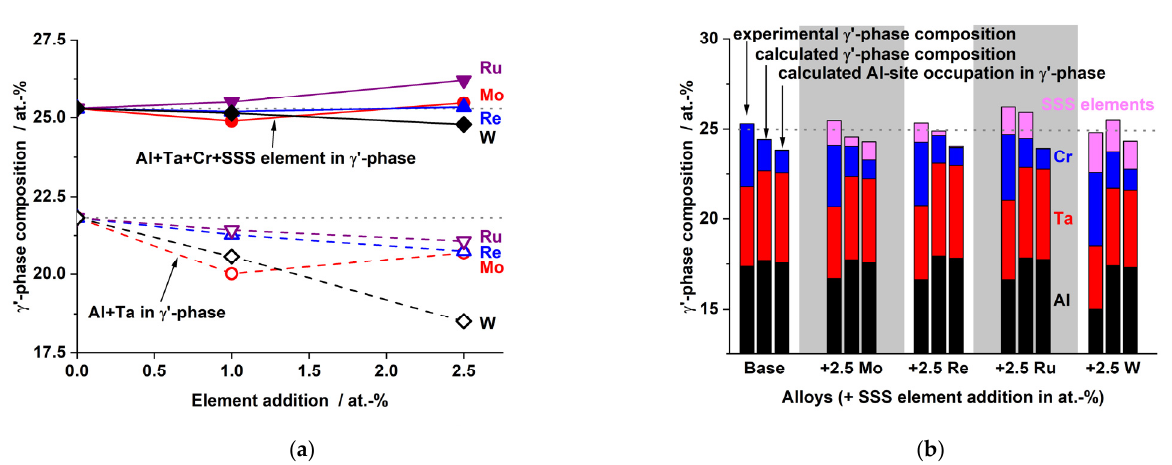
Figure 5. Element concentrations in the γ ‘-phase: ( a ) The alloys containing Mo, Re and W show decreasing sums of experimentally determined (EPMA) Al + Ta concentrations and a relatively constant value of about 25 at.-% for the sum of Al + Ta + Cr + SSS elements, whereas the Ru effect is different; ( b ) comparison of the experimentally measured composition (left column) with ThermoCalc calculated (middle column) composition of the γ′ -phase. The right column shows the occupation of Al sites in the γ′ -phase calculated with ThermoCalc.